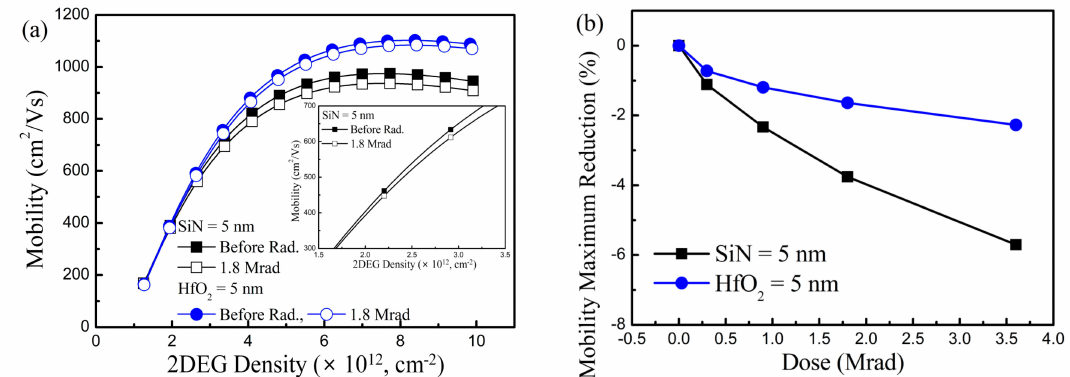
Figure 6. Carrier mobility deterioration according to the γ -ray radiation. ( a ) Carrier mobility as a function of 2DEG density before and after the γ -ray radiation with the doses of 1.8 Mrad. ( b ) Carrier mobility maximum reduction as a function of irradiated γ -ray doses. Inset in Figure 5a shows the zoomed-in carrier mobility behavior at low 2DEG density regime in Sample-SiN before and after the γ -ray radiation with doses of 1.8